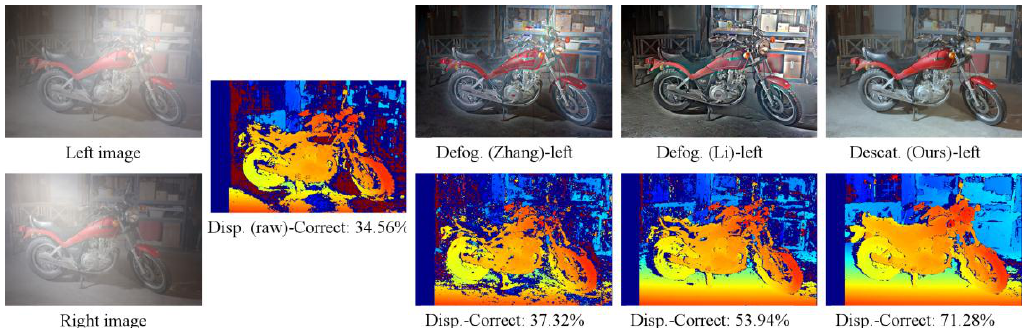
Figure 6. An example of synthetic images of Motor in the case of lighting 2 and uniform fog: The first column is corrupted images; the second is disparity from input images; the third to the last columns are the defogged (or descattered) images and disparity maps obatined by using the methods in [35,36] and the proposed method, respectively.